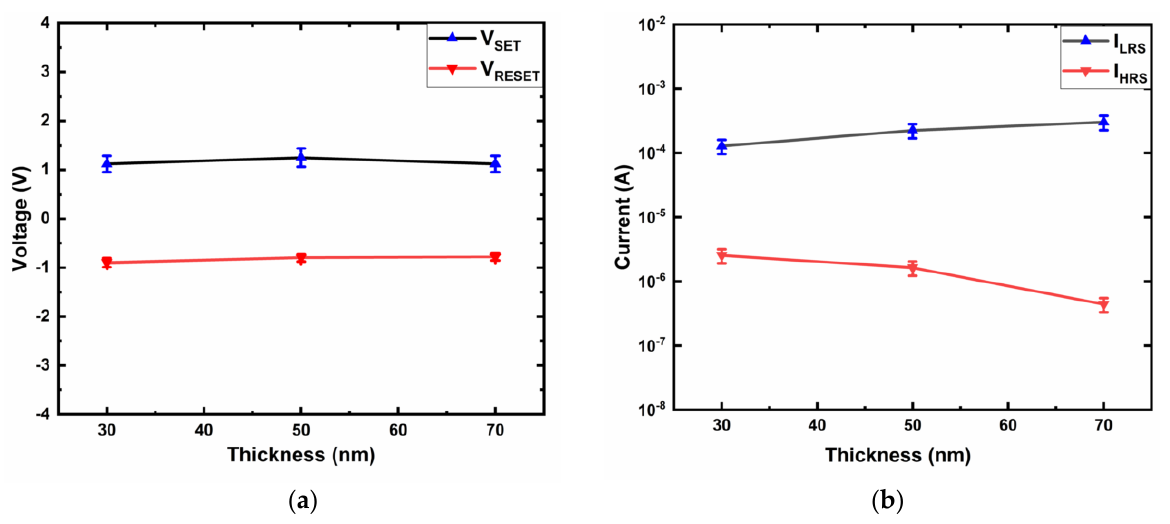
Figure 4. Active layer thickness dependent characteristics of Ti/MgF x /Pt memory devices. ( a ) SET and RESET voltage vs. thickness; ( b ) On and Off current vs. thickness.